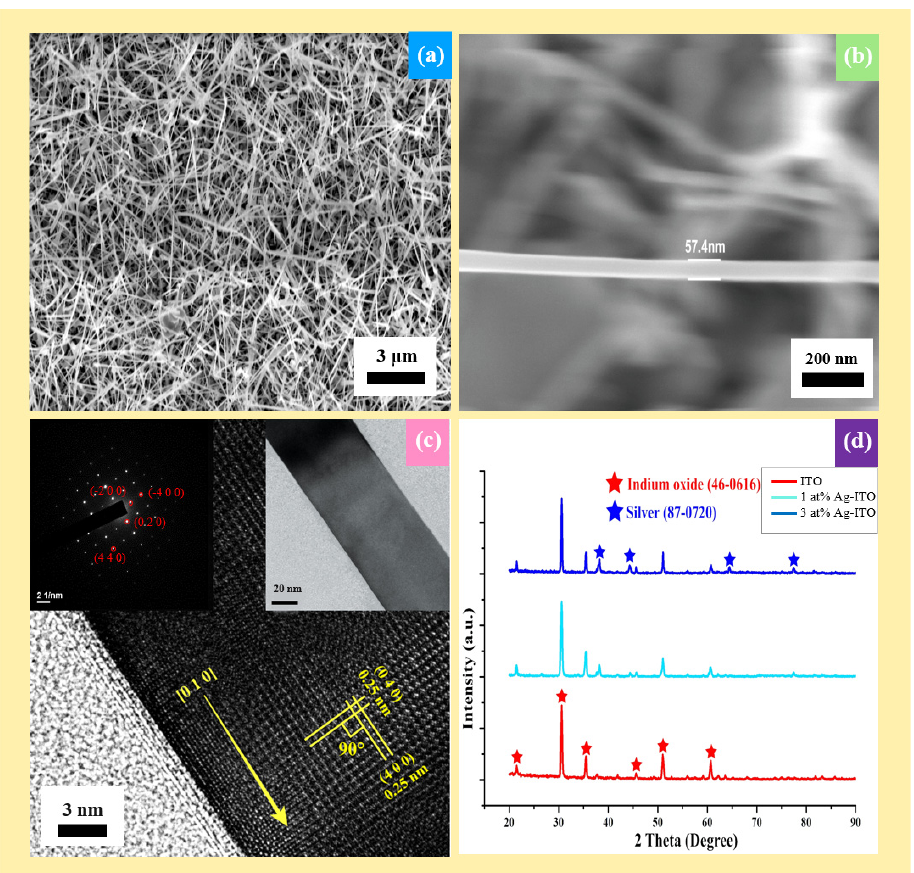
Figure 2. Structural characterization of ITO NWs ( a ) SEM image of ITO NWs ( b ) SEM image of a cross-section of an ITO NW ( c ) HR-TEM image of the ITO NW, showing two interplanar spacings of 0.25 nm corresponding to (0 4 0) and (4 0 0) planes. Insets are the SAED pattern and low-magnification TEM image of the NW. ( d ) XRD spectra, where the red line denotes ITO, the light blue line denotes 1 at% Ag-ITO NW, and the blue line denotes 3 at% Ag-ITO